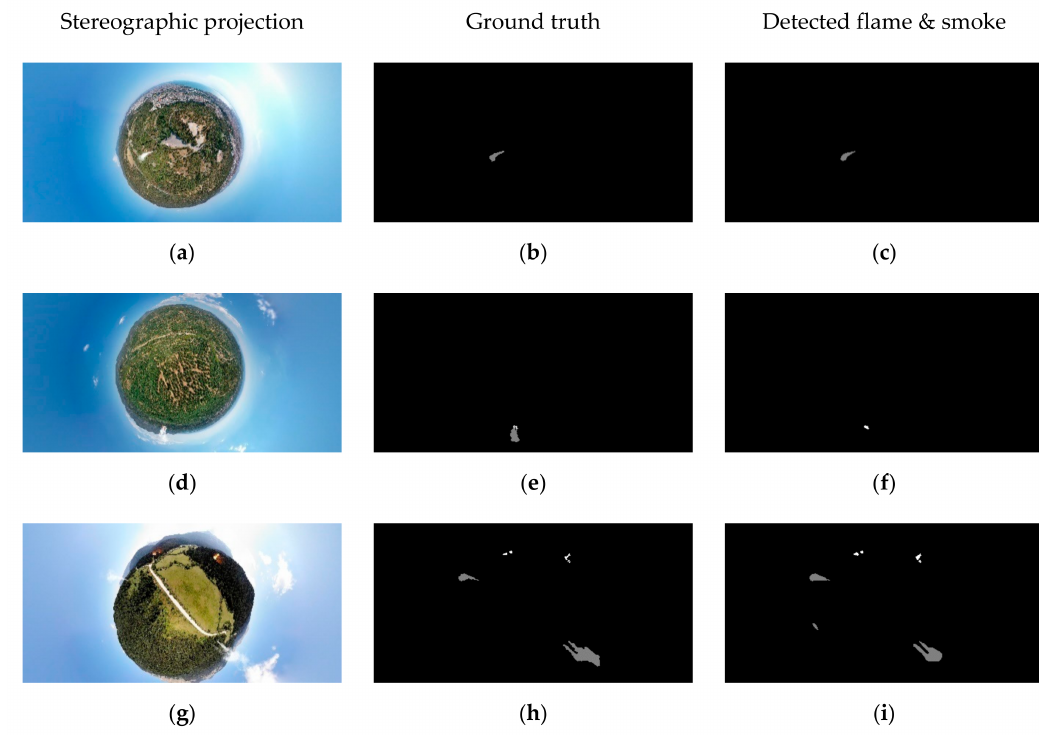
Figure 7. Results of the proposed methodology in 360-degree images containing synthetic fire events of the “Fire detection 360-degree dataset”. Equirectangular “360-FIRE-B” images containing flame ( a–c ), containing smoke ( d–f ) and containing both flame and smoke ( g–i ).